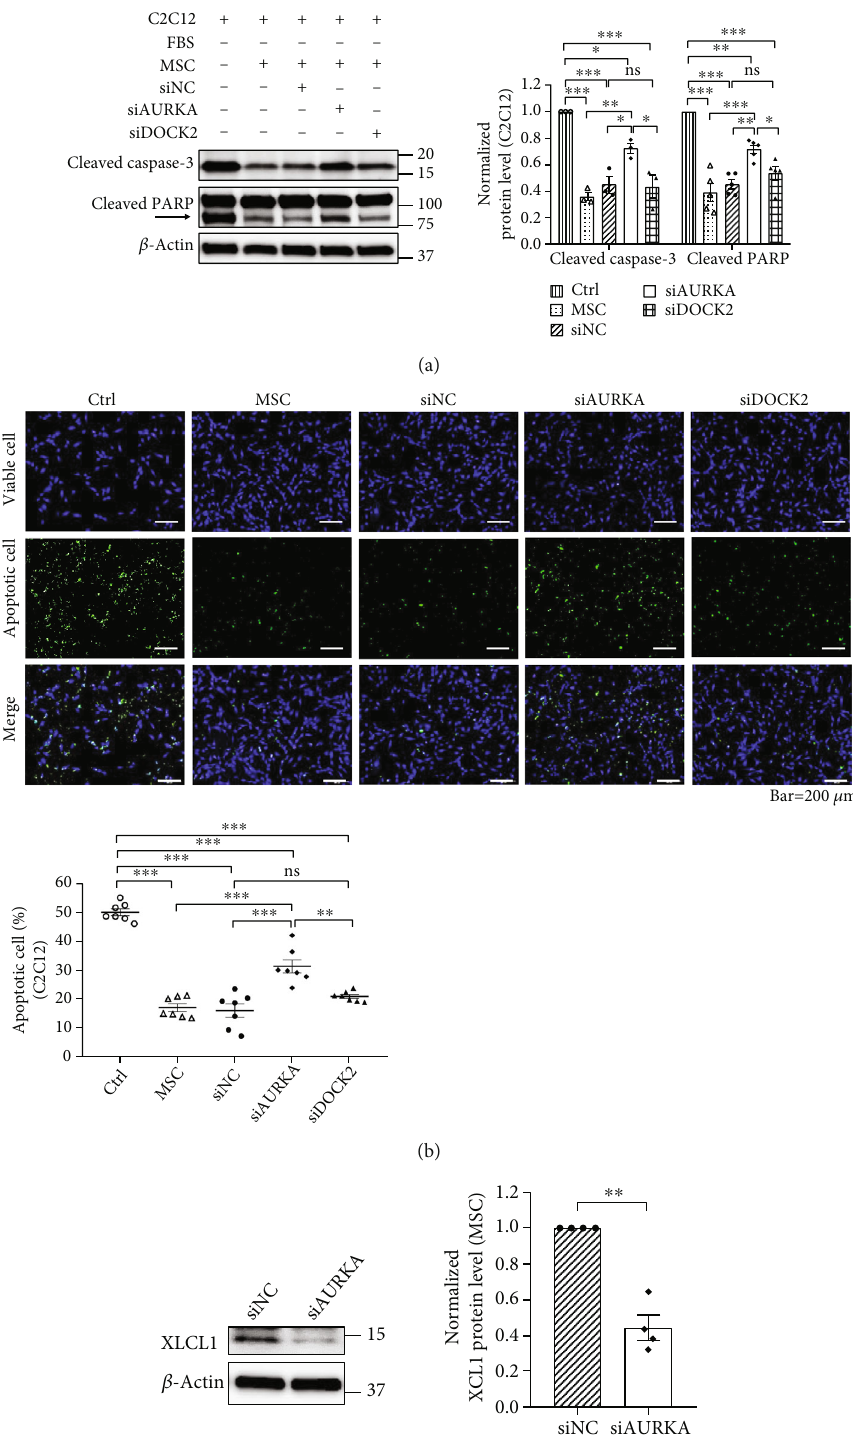
Figure 5: Knockdown of AURKA inhibited antiapoptotic e ff ect of WJ-MSCs and was accompanied by the reduction of XCL1 protein. (a) Western blotting of the protein expression levels of cleaved caspase-3 and cleaved PARP in apoptosis-induced C2C12 cells. Normalized protein level indicates the value converted based on that of the control group. (b) Representative fl uorescence images showed whether the suppression of AURKA and DOCK2 inhibited antiapoptotic e ff ects of WJ-MSC in C2C12 (green, apoptotic cells; blue, viable cells). (c) Western blotting of the expression level of XCL1 protein in siAURKA-transfected WJ-MSCs. Normalized protein level indicates the value converted based on that of the siNC group. Data are shown as means ± SEM . One-way ANOVA with Tukey ’ s multiple comparisons test (a, b). Two-tailed Student ’ s t -test (c). ∗∗∗ p < 0 : 001 , ∗∗ p < 0 : 01 , and ∗ p < 0 : 05